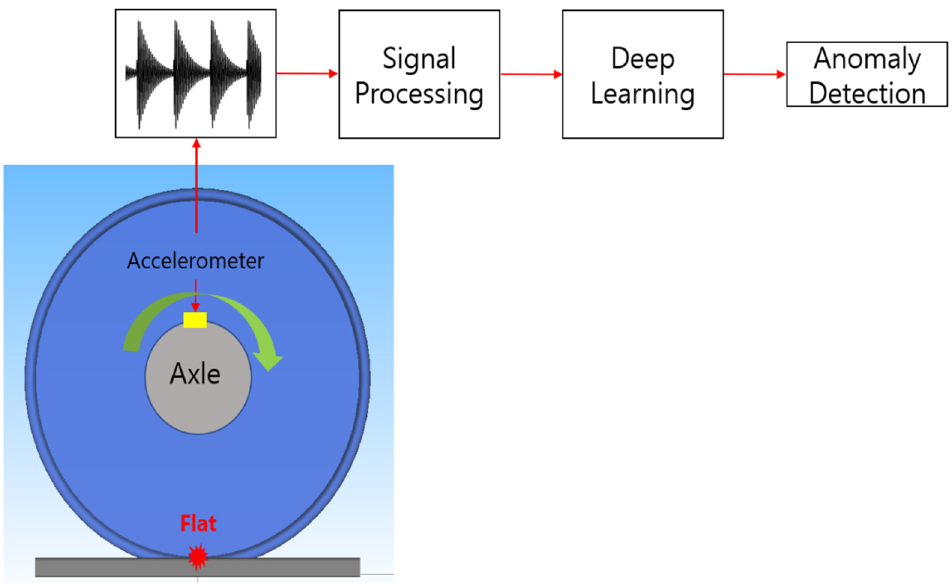
Figure 11. Schematic of the instrumentation setup for wheel flat measurements [21].